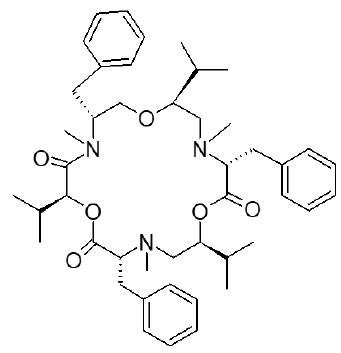
Figure 1. Beauvericin chemical structure.